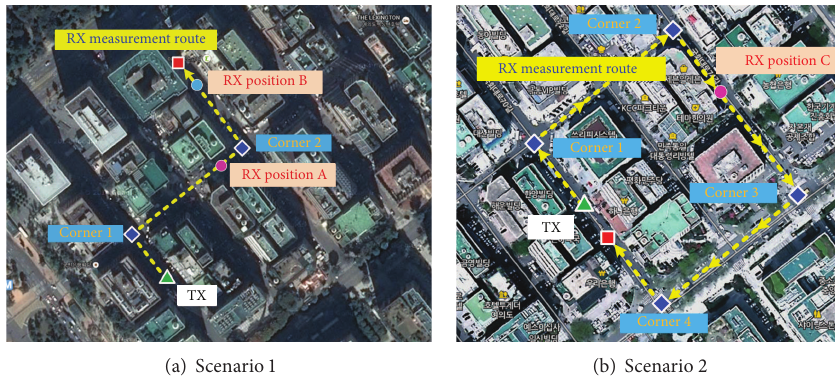
Figure 4: Measurement route in Seoul City: TX was held at a stationary position while RX moved along the dotted route path.